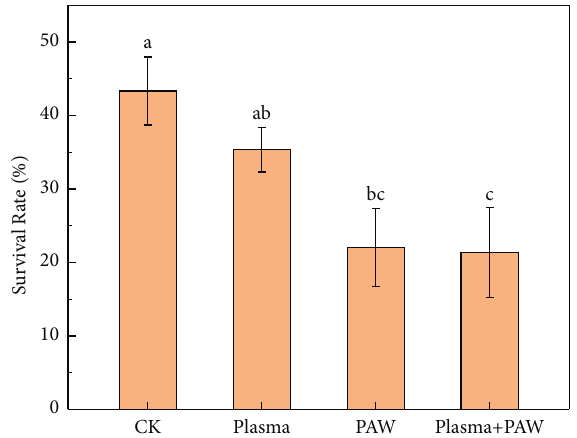
Figure 15: Survival rate of Astragalus adsurgens Pall (different letters indicate statistically significant differences between treat- ments ( p < 0 . 05)).